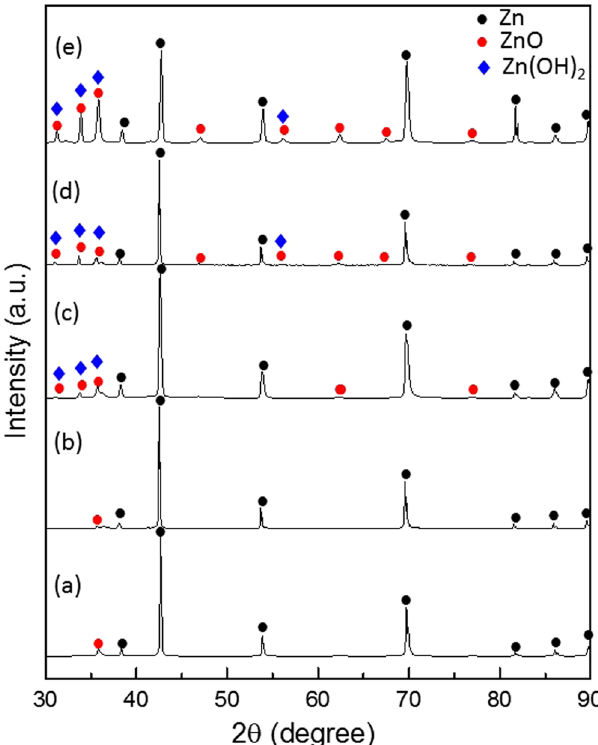
Figure 2. X-ray diffraction patterns of the Zn specimens after ( a ) plasma pretreatment, ( b ) 1 h of UV irradiation, ( c ) 13 h of UV irradiation, ( d ) 24 h of UV irradiation, and ( e ) 72 h of UV